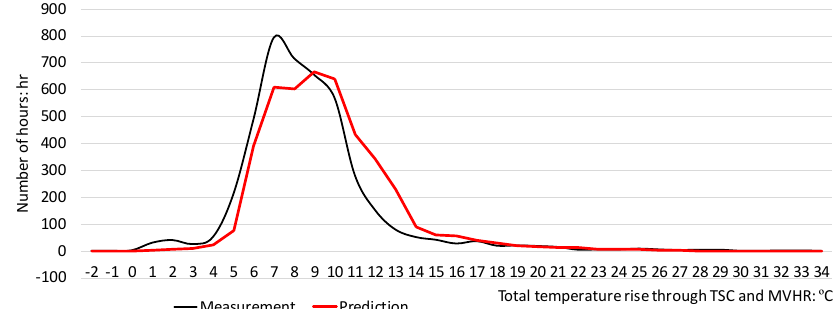
Figure 7. Hourly distribution of temperature rise through the TSC and MVHR (October 2015 to March 2016), comparing predicted (red) with measured (black) data.